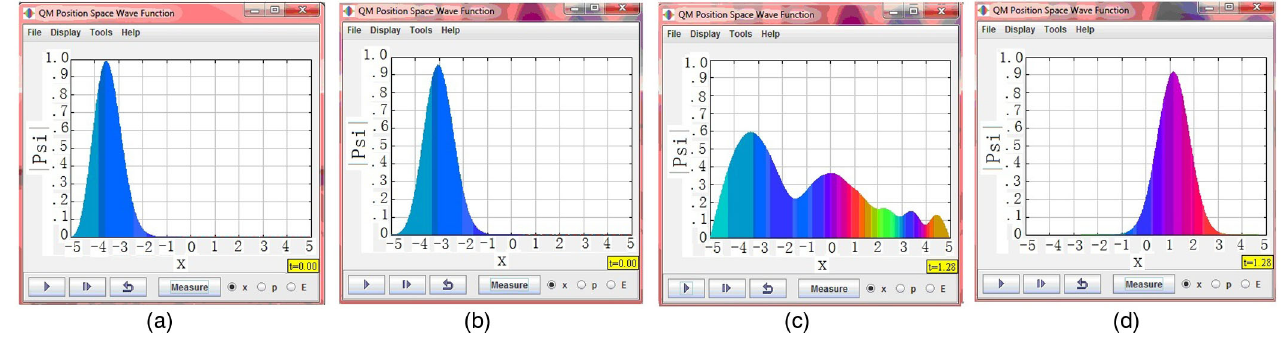
FIG. 9 (color online). Consecutive position measurement in quick succession (a),(b) and after waiting for some time